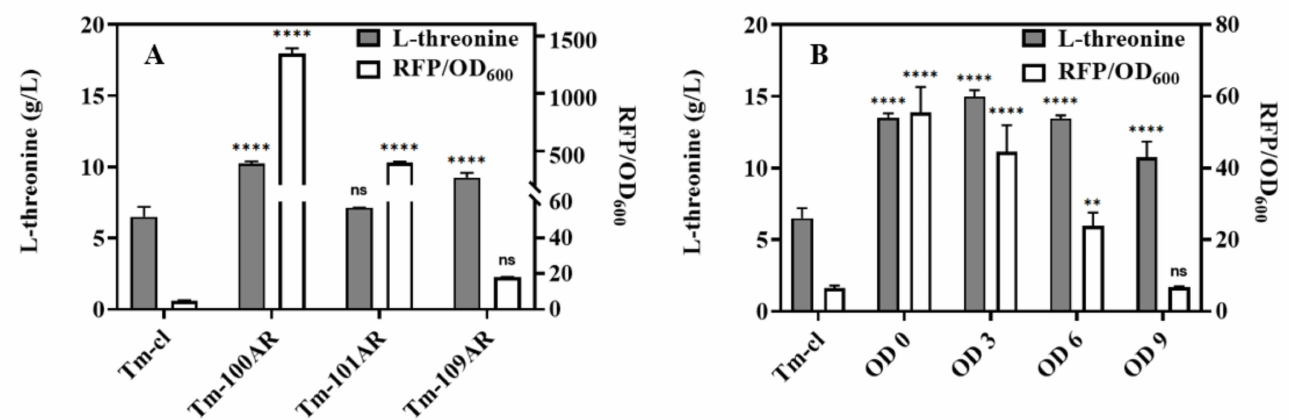
Figure 2. Adding IPTG at different growth stages to dynamically control rhtA expression. ( A ) rhtA was constitutively expressed with strong (promoter J23100), medium (promoter J23101), and weak (promoter J23109) intensities in strains Tm-100AR, Tm-101AR, and Tm-109AR, respectively. Strain Tm-cl without overexpressed rhtA as the control. ( B ) The Tm-AR strain containing overexpressed rhtA was induced with 0.5 mM of IPTG at OD 0, 3, 6, and 9. L-threonine titers were measured at 36 h of fermentation. All results were calculated with three ( n = 3) independent replicates. Error bars represent mean ± SEM. **** p < 0.0001, ** p < 0.01. ns: